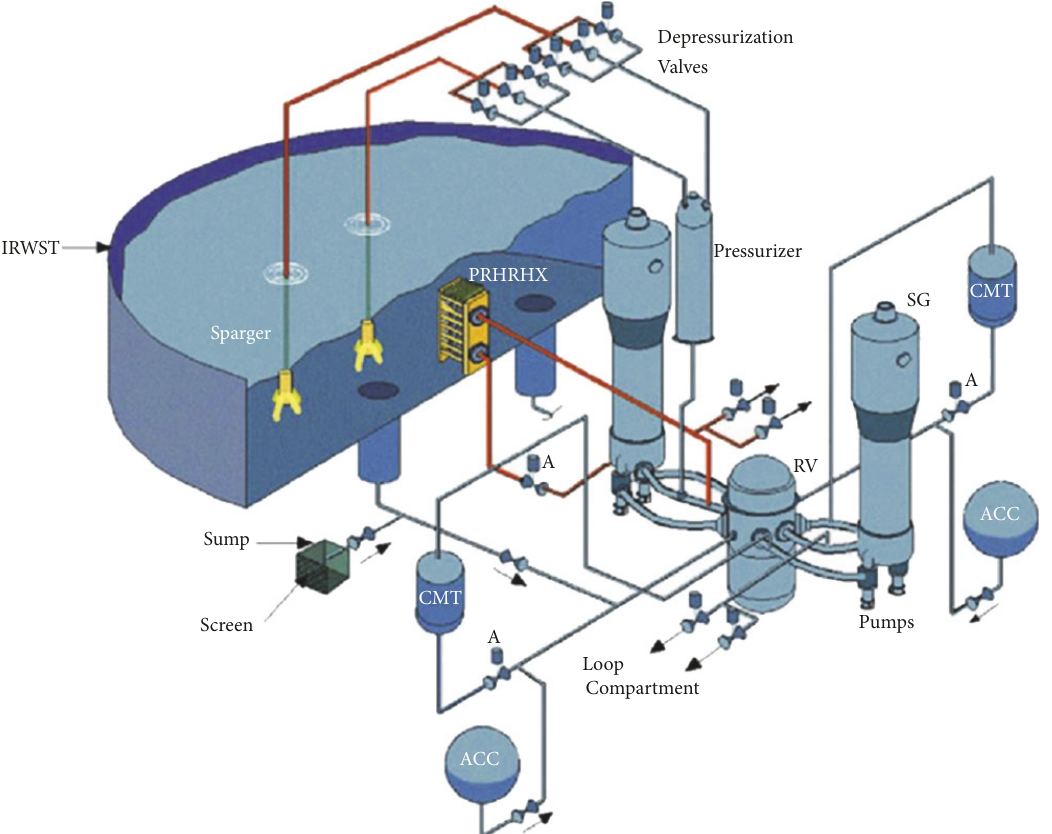
Figure 1: AP1000 reactor coolant system and passive core cooling